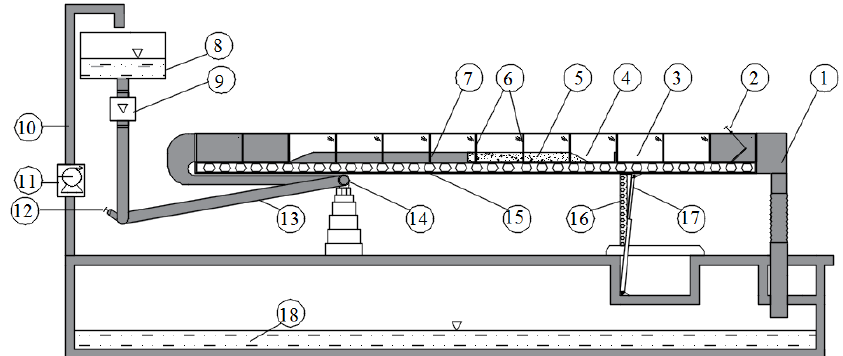
Figure 3. Experimental channel scheme—side view. Where: 1—chute chamber; 2—the regulatory gate; 3—glass side wall; 4—collection chamber; 5—sandy bed; 6—supports for sidewalls; 7—solid bottom; 8—upper reservoir; 9—electromagnetic flowmeter; 10—a pipeline conducting water; 11— the